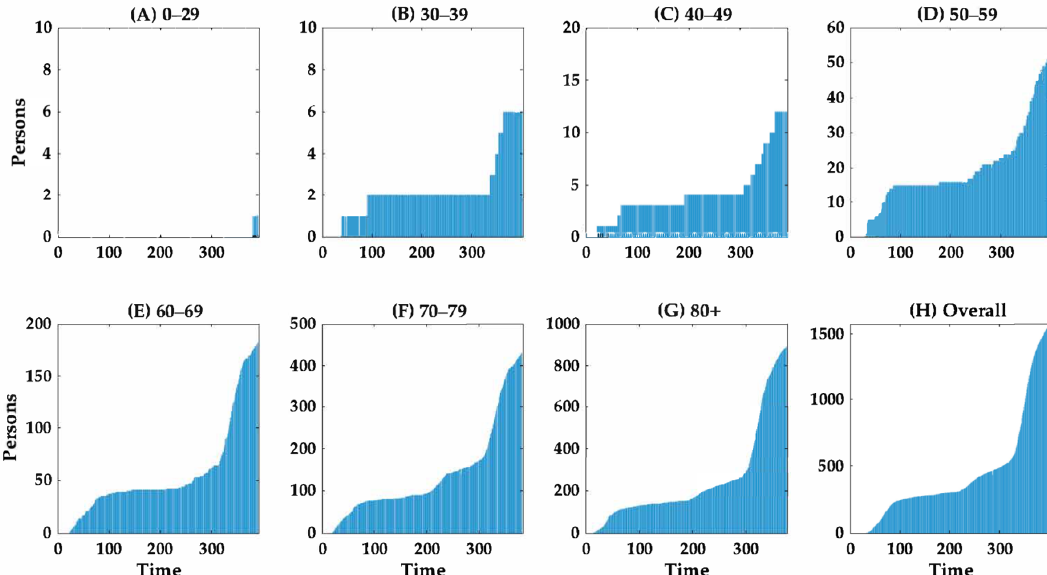
Figure 4. Temporal distribution of cumulative COVID-19 deaths according to age group in South Korea from 20 February 2021 to 23 February 2021. The cumulative number of COVID-19 deaths are shown according to the following age groups: ( A ) 0–29 years, ( B ) 30–39 years, ( C ) 40–49 years, ( D ) 50–59 years, ( E ) 60–69 years, ( F ) 70–79 years, ( G ) ≥ 80 years and ( H ) all COVID-19 deaths. Day 1 corresponds to 20 February 2021. The scale on the Y -axis differs according to age group.